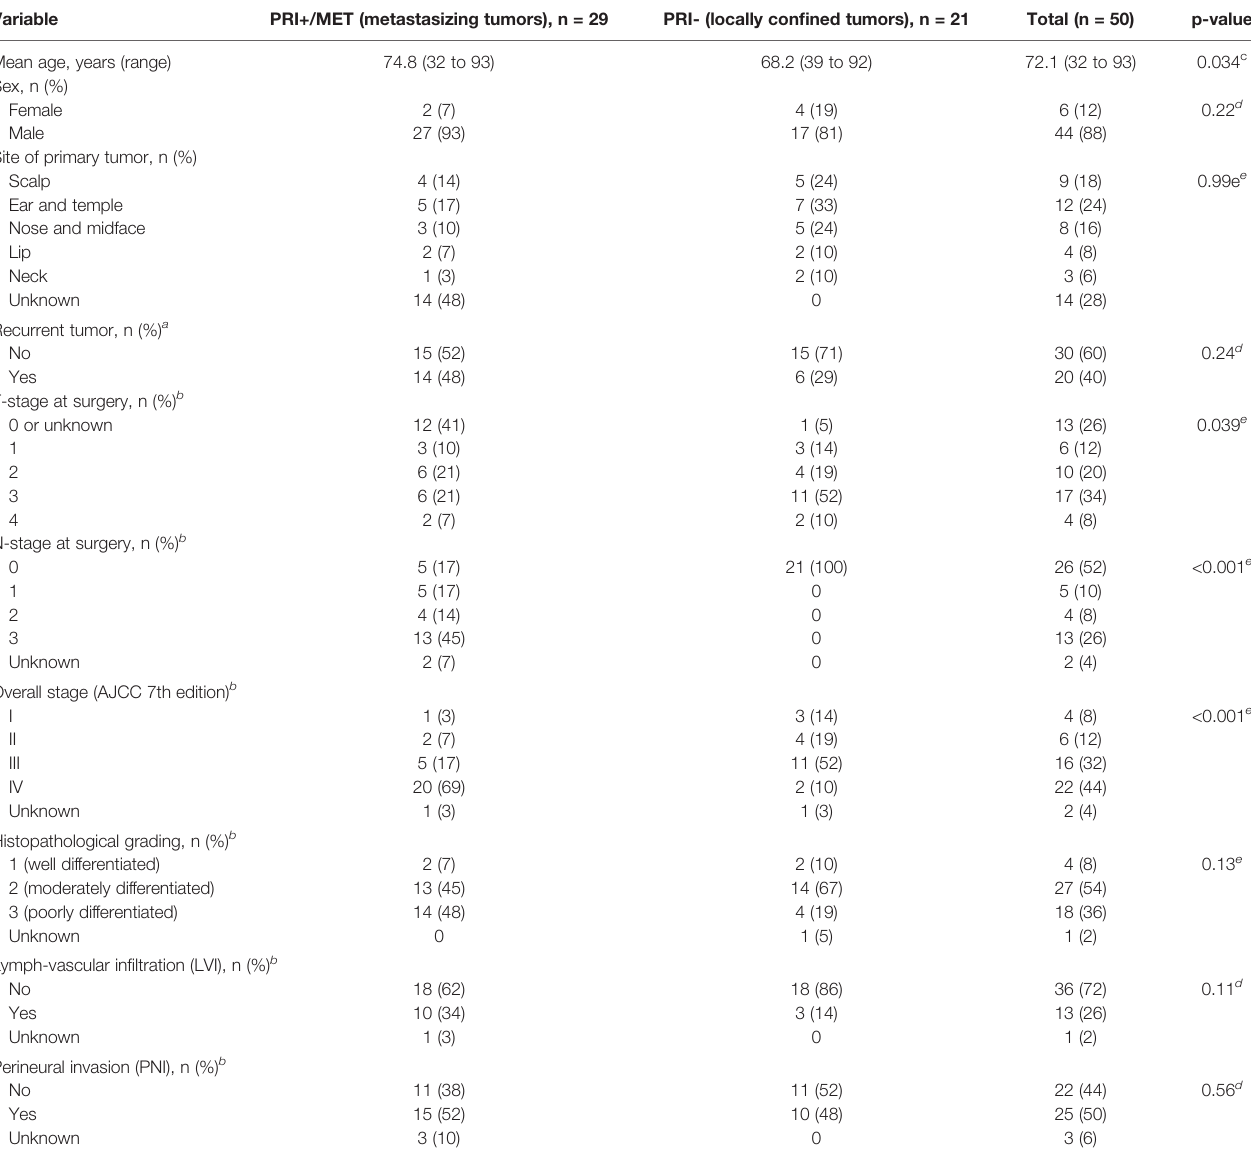
TABLE 1 | Demographic and clinical data of the cohort of 50 patients with cSCC with (cohorts PRI+, MET) or without lymph node metastasis (PRI-). Variable PRI+/MET (metastasizing tumors), n =